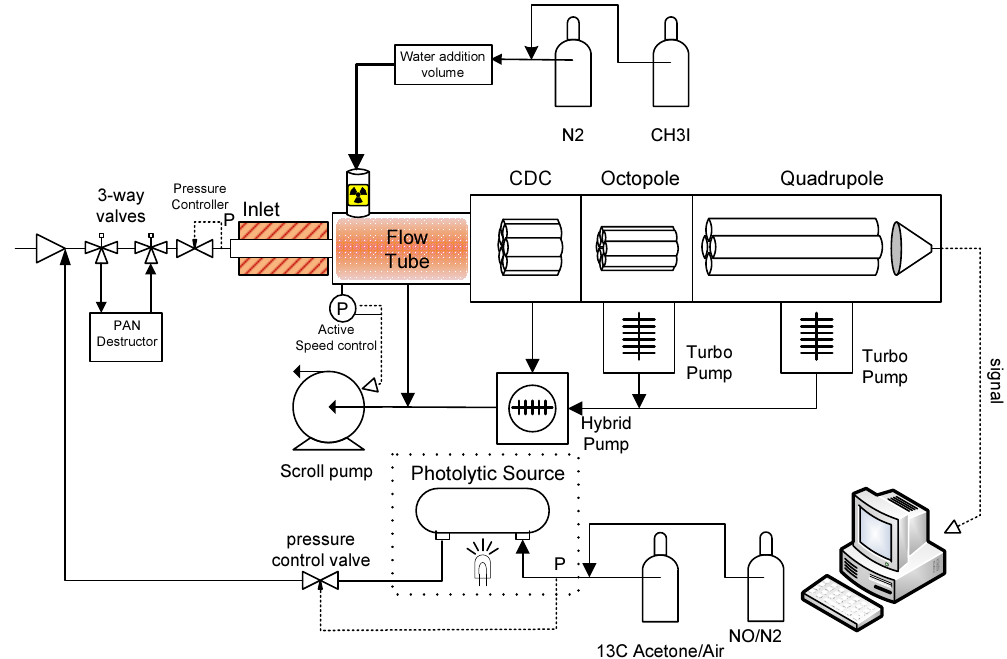
Fig. 1. Diagram of TD-CIMS. CDC=Collision Dissociation Chamber. The turbo pumps are Varian, Inc. model V70LP, The hybrid pump is an Adixen model ATH31+, and the Scroll pump is an Air Squared, inc. 100lmin − 1 model. A water addition volume is placed inline with the reagent gas, to ensure that the instrument sensitivity does not depend on ambient humidity. The PAN standard is produced in a photolytic source and fed into the inlet for in-situ